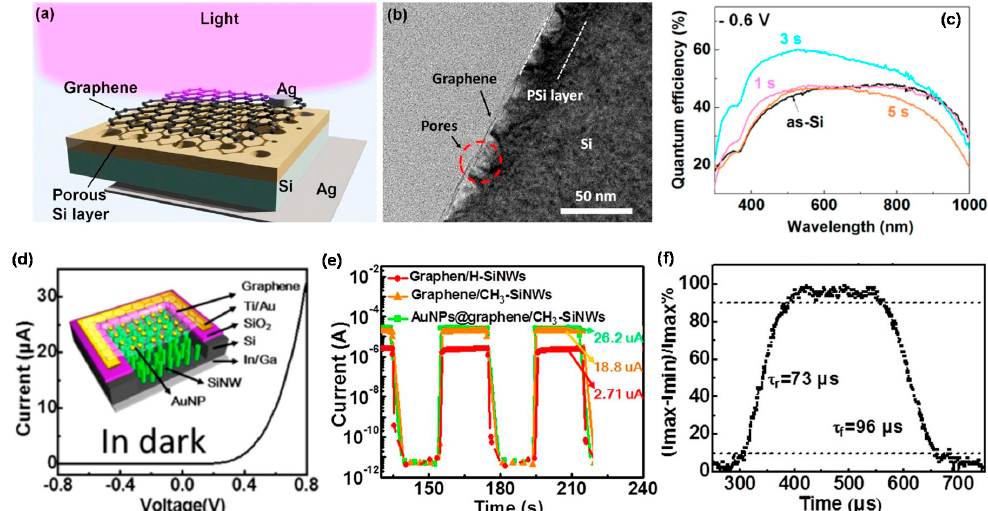
Figure 2. ( a ) Schematic diagram of graphene/PSi/n-Si PD with silver top and bottom electrodes under light illumination; ( b ) Cross-sectional transmission electron microscopy (TEM) image of graphene/PSi junction; ( c ) Quantum efficiencies of as-Si, 1, 3, and 5 s PDs (Here, 1, 3, and 5 s mean the deposition time ( t d ) of Ag nanoparticles. That is, the pore on the surface of the PSi increases as the time increases, Reproduced with permission for Figure 2a–c from 2014 ACS Applied Materials & Interfaces [35]; ( d ) Current-voltage curves of the Au NPs-graphene/SiNWs array PD. The inset shows the device structure; ( e ) Photoresponse of three representative devices under 850 nm light illumination at V = 0; ( f ) A single normalized cycle measured at 2200 Hz for estimating both rise time ( t r ) and fall time ( t f ). Reproduced with permission for Figure 2d–f from 2014 Scientific Reports [36].